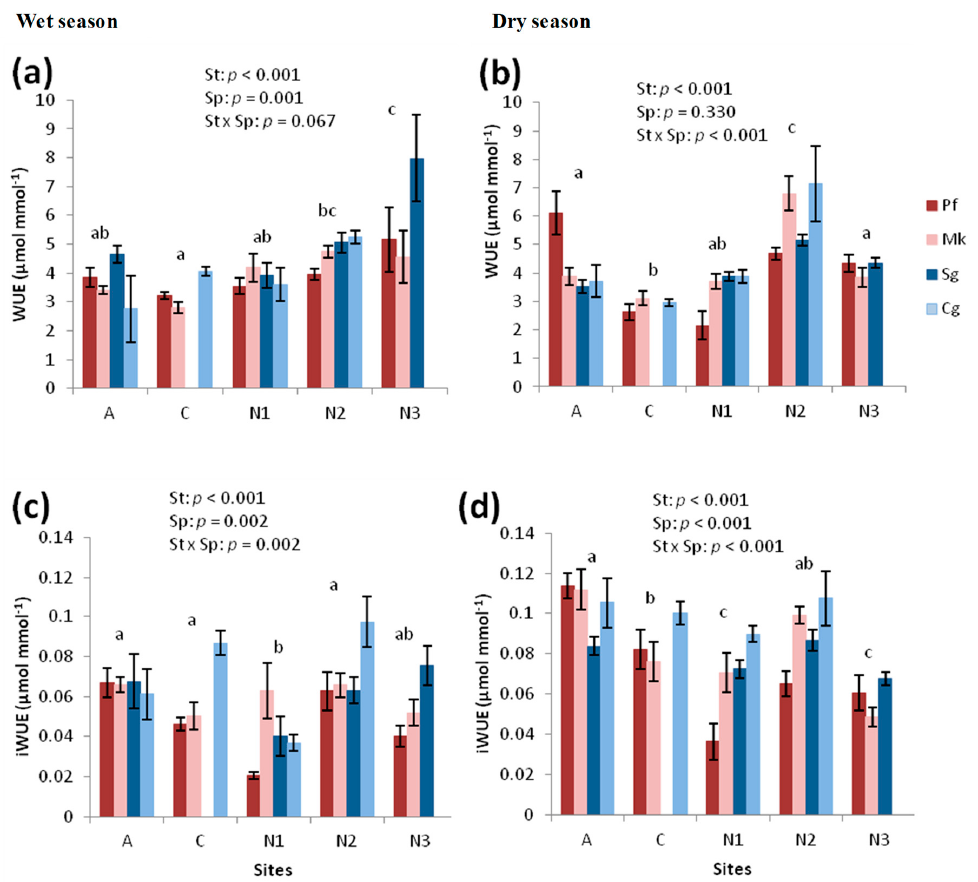
Figure 2. Water use efficiency (WUE = A n / E ; ( a , b )) and intrinsic water use efficiency (iWUE = A n / g s ; ( c , d )) determined by gas exchange measurements. Data are for four species (Sp) at five sites (St) along an elevation gradient, measured during wet ( a , c ) and dry ( b , d ) seasons. Significant overall differences among sites are indicated by different letters above the bars of each site. Explanations of site abbreviations and species names are provided in Table 1 and Figure 1, respectively; the site order follows increasing elevation from left to right.